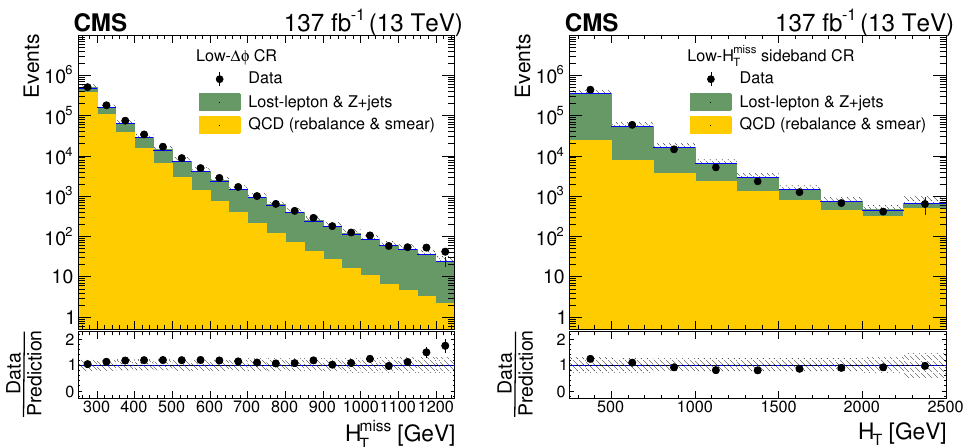
Figure 8 . The observed and predicted distributions of (left) H miss in the inverted-(cid:1) (cid:30) control T region and (right) H in the low- H miss sideband. The uncertainties are statistical only. The T T lower panels show the ratios of the observed to the predicted distributions, with their statistical uncertainties. The hatched regions indicate the total uncertainties in the predictions, with statistical and systematic uncertainties combined in